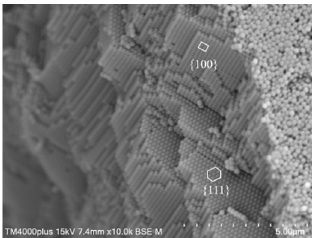
Figure 5. SEM image of microcracks formed during the drying of the coating.